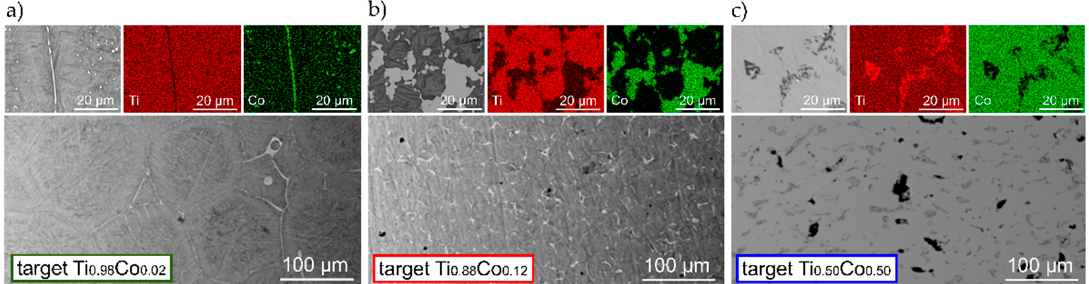
Figure 1. Microstructure with WDS maps of elemental distribution of Ti and Co in sintered targets: ( a ) Ti 0.98 Co 0.02 , ( b ) Ti 0.88 Co 0.12 , ( c ) Ti 0.50 Co 0.50 .